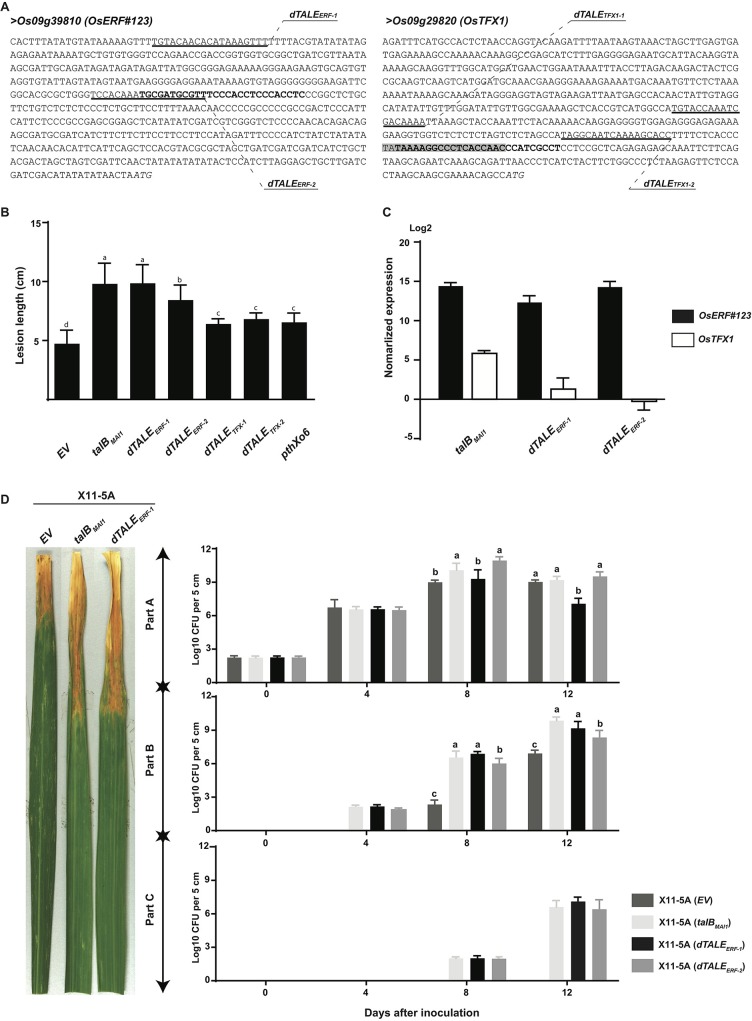
TalBMAI1 targets OsTFX1 and a novel S gene OsERF#123.(A) DNA sequence of the promoter regions of TalBMAI1-induced genes Os09g39810 (aka OsERF#123) and Os09g29820 (aka OsTFX1) in rice cv. Nipponbare. The effector binding elements (EBEs) for TalBMAI1 and PthXo6 from the Asian Xoo strain PXO99A are depicted in bold and highlighted in gray, respectively. The EBEs for gene-specific dTALEs used in panels B and C are underlined and labeled. Italics indicate translational start sites, based on the rice Nipponbare v. MSU7 genome (http://rice.plantbiology.msu.edu/). (B) dTALEs targeted to OsERF#123 and dTALEs targeted to OsTFX1 increase the virulence of Xo strain X11-5A. Rice leaves of Azucena were inoculated by leaf-clipping with derivatives of X11-5A carrying an empty vector (EV) or expressing talBMAI1, dTALEERF-1, dTALEERF-2, dTALETFX-1, dTALETFX-2 or pthXo6. Lesion length was measured at 15 days after inoculation (dai). Data are the mean of at least eight measurements. Error bars represent +/- SD. Bars with same letters are not statistically different based on a Tukey’s multiple comparisons test (α = 0.05). Data were plotted and statistical analyses were performed using the Graphpad prism 6 software. (C) dTALEERF-1 and dTALEERF-2 specifically activate OsERF#123 but not OsTFX1. The expression levels of OsERF#123 and OsTFX1 were evaluated by quantitative reverse transcription polymerase chain reaction (qRT-PCR) 24 hours after syringe infiltration of Azucena rice leaves with X11-5A strains carrying an empty vector (EV) or derivatives expressing talBMAI1, dTALEERF-1 or dTALEERF-2. Gene expression was normalized against X11-5A (EV). Error bars represent +/- SD. (D) Population size and distribution of X11-5A(EV), X11-5A(ptalBMAI1), X11-5A(pdTALEERF-1) and X11-5A(pdTALEERF-2) in leaves of cultivar Azucena following leaf-clipping inoculation. Four-week-old plants were inoculated and bacterial populations in 5cm leaf segments were measured at 0, 4, 8, and 12 days after inoculation. Values represent averages of three inoculations. The experiment was repeated three times with similar results. Error bars represent +/- SD. Bars with the same letters are not statistically different, based on a Tukey’s multiple comparisons test (α = 0.05). Data were plotted and statistical analyses were performed using the Graphpad prism 6 software. Left panel: representative lesions photographed at 14 dai. This experiment was reproduced three times with similar results.